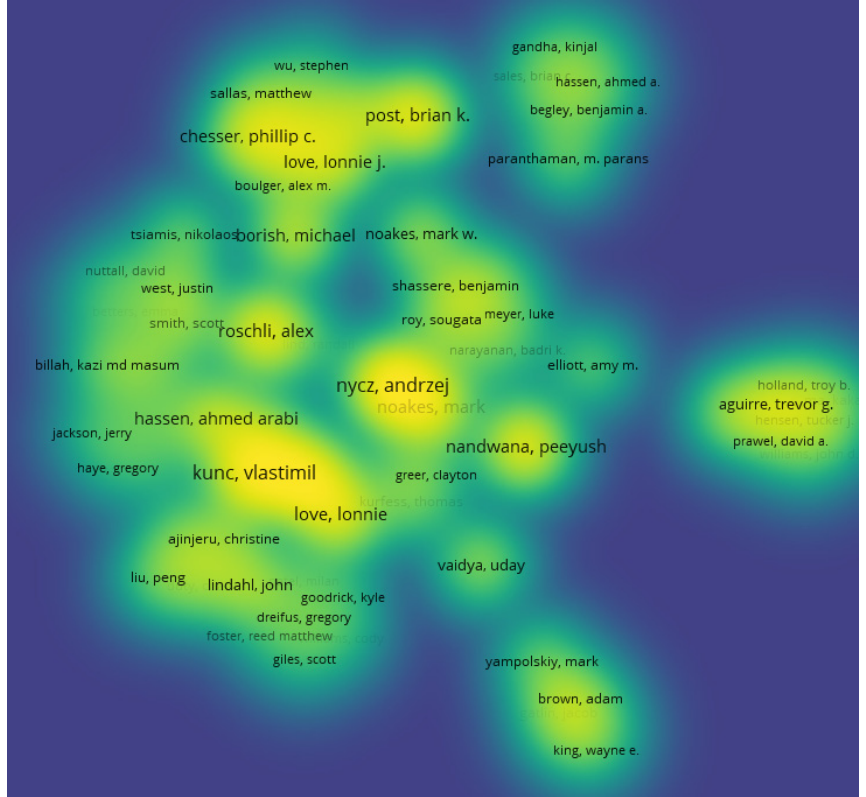
Figure 22. Mapping based on co-authorship showing the density visualization for the second method.